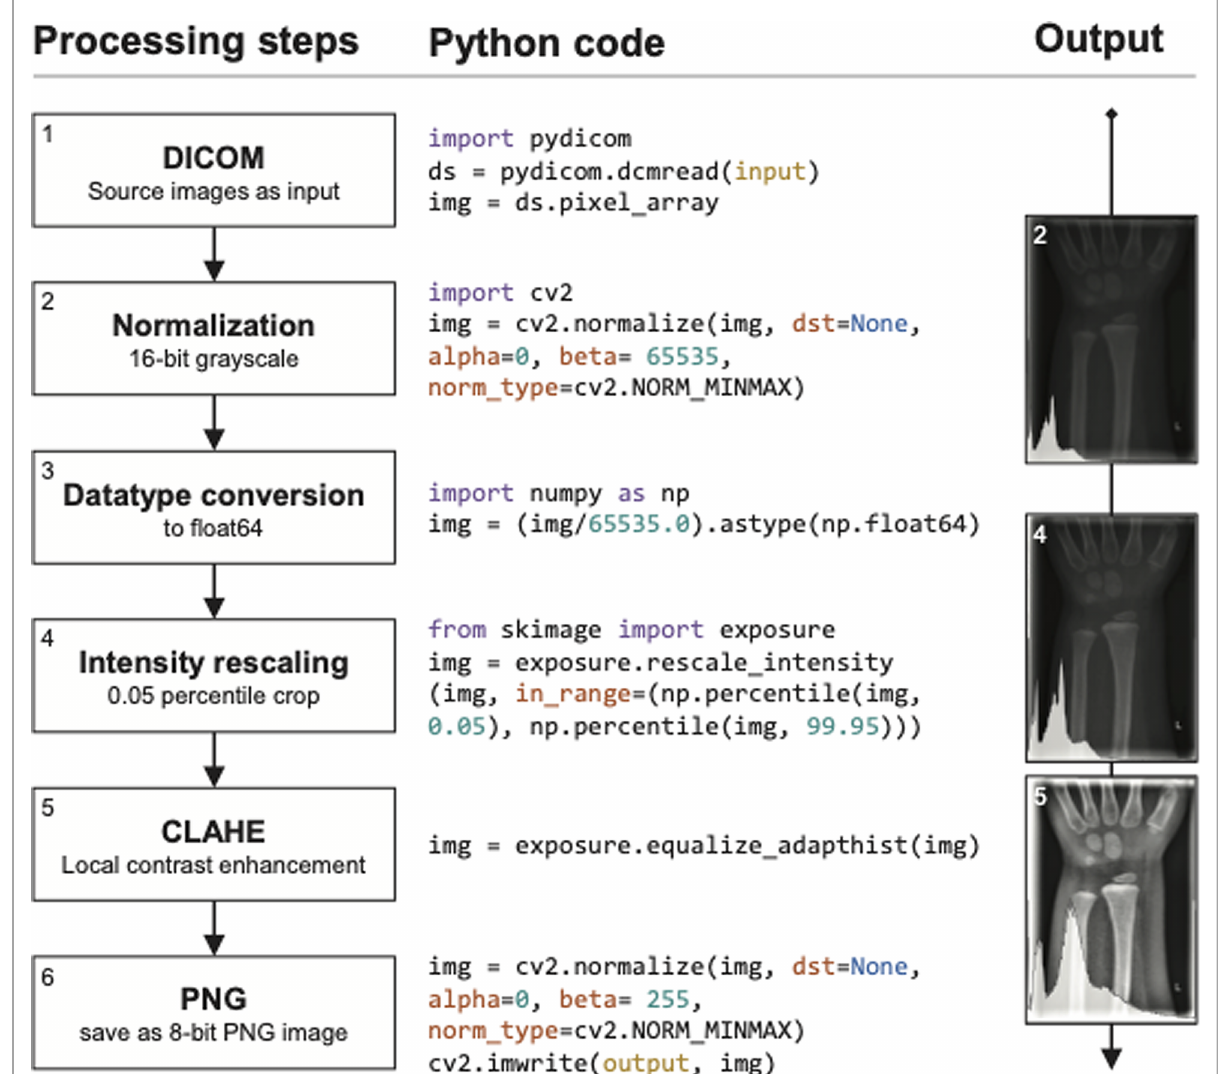
FIGURE 2 Image processing steps. DICOM images served as input, 8-bit PNG images as output used in training neural networks and human expert